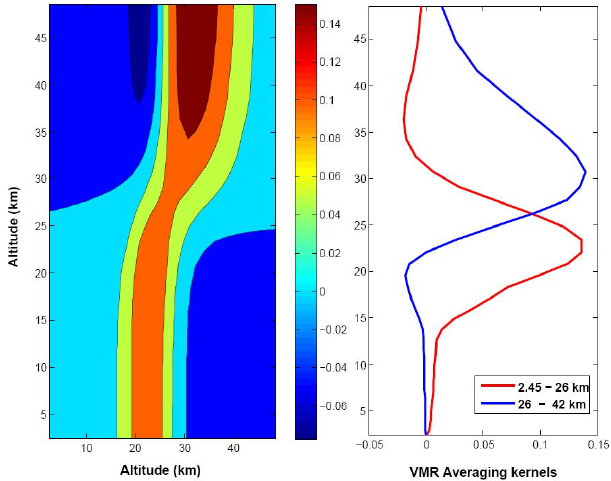
Fig. 3. The left panels show O 3 averaging kernels matrix and the right panels depict rows of averaging kernels (ppmvppmv − 1 ) for two altitude ranges shown in the legend for retrieval based on FTIR observation taken on 27 May 2010.